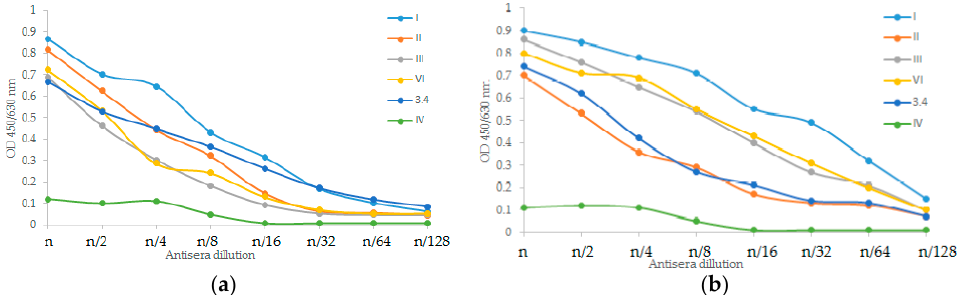
Figure 3. Immunochemical characterization of PLVF and nLPS of S. flexneri . Specific activity was investigated by ELISA of: ( a ) PLVF and ( b ) nLPS of S. flexneri 1b, 2a, 3a, 6, and Y using monovalent antisera against type-specific antigens I, II, III, and VI, and group-specific antigen 3,4, respectively. Type IV-specific antiserum was used as a negative control. (n − starting serum dilution).